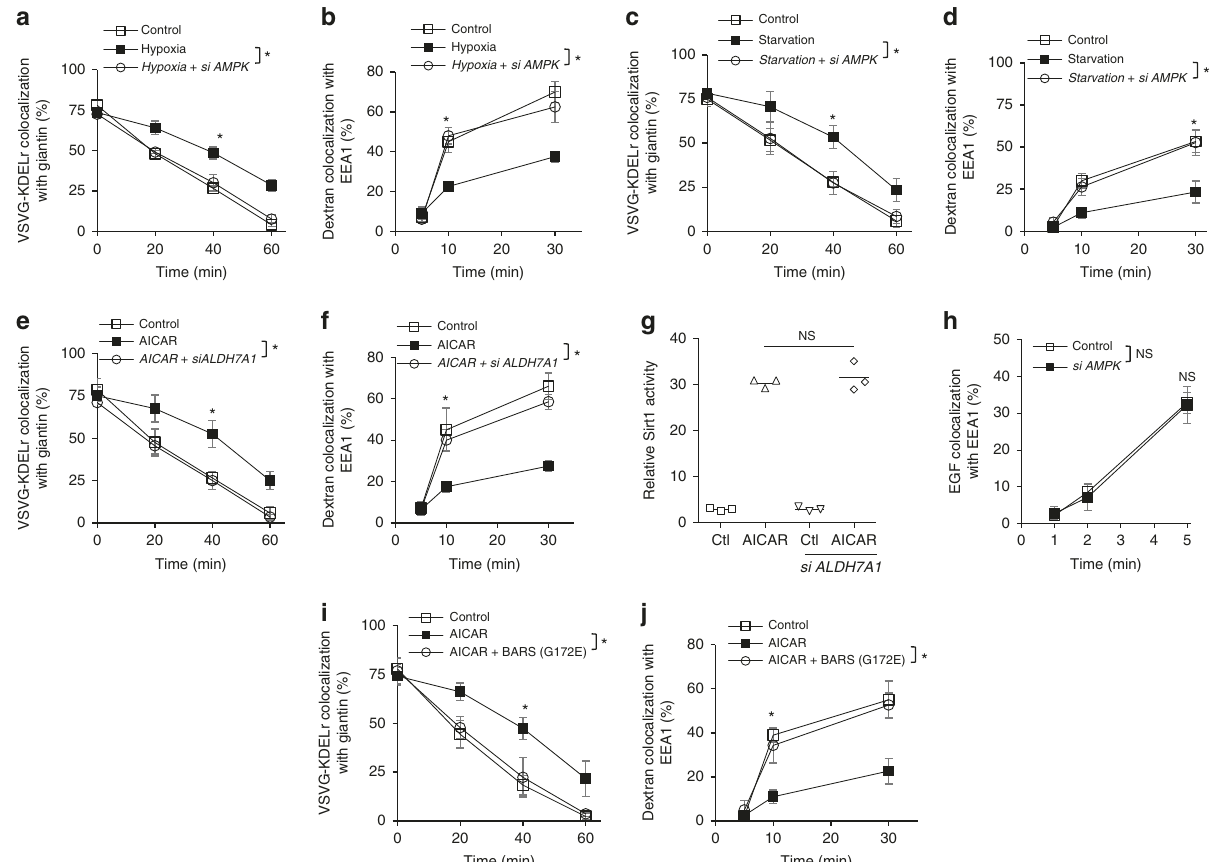
Fig. 8 AMPK inhibits the transport pathways through ALDH7A1. Quantitative results are shown as mean with standard deviation; * p < 0.05, NS not signi fi cant, paired two-tailed Student ’ s t -test; n = 3 independent experiments. Source data are provided as a Source Data fi le. a COPI transport from the Golgi to the ER in HeLa cells was assessed through the quantitative colocalization of VSVG-KDELR with a cis -Golgi marker (giantin). b Fluid-phase endocytosis of dextran in HeLa cells was assessed through the quantitative colocalization of internalized dextran with an early endosome marker (EEA1). c COPI transport from the Golgi to the ER in HeLa cells was assessed through the quantitative colocalization of VSVG-KDELR with a cis -Golgi marker (giantin). d Fluid-phase endocytosis of dextran in HeLa cells was assessed through the quantitative colocalization of internalized dextran with an early endosome marker (EEA1). e COPI transport from the Golgi to the ER in HeLa cells was assessed through the quantitative colocalization of